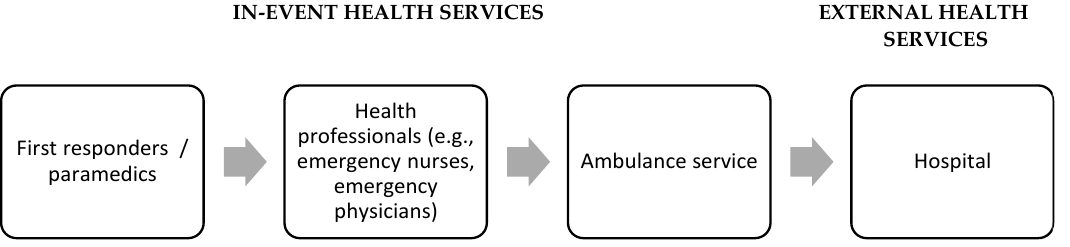
Figure 1. Hierarchy of Clinical Care at Belgian Mass Gatherings (Modified from Ranse et al., 2017 [4]). To mitigate the impact of the MGE on regular emergency departments in the region, IEHS maximized its efficiency by organizing six medical posts—three on the festival site during festival hours and three at the camping site, irrespective of festival hours. Onsite medical care was provided by first-aid responders, paramedics, emergency nurses, and emergency